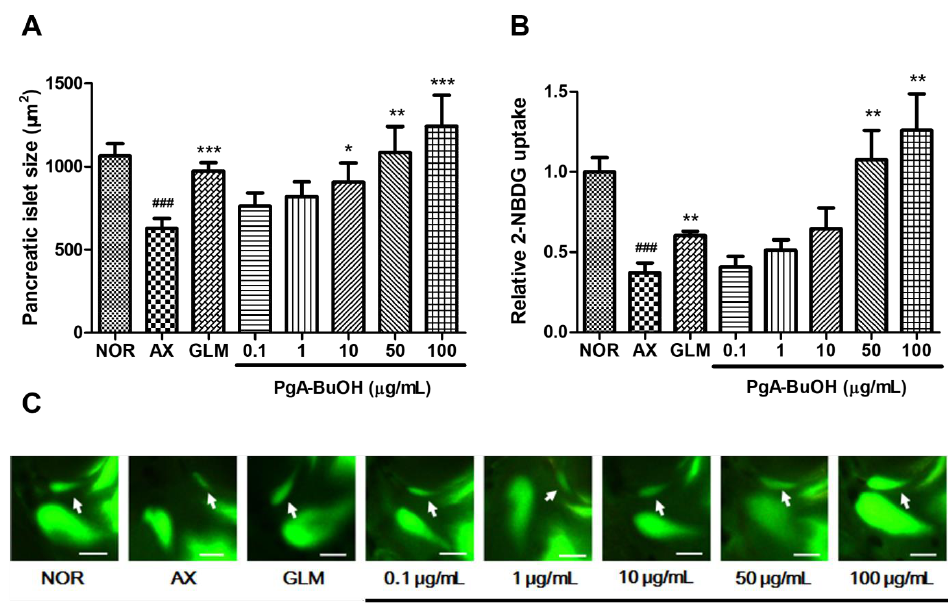
Figure 4. Dose-dependent effects of the PgA-BuOH fraction on alloxan-induced diabetic zebrafish. ( A ) Change in pancreatic islet size caused by the GLM and PgA-BuOH fraction; ( B ) relative 2-NBDG uptake in pancreatic islet caused by GLM and PgA-BuOH; ( C ) fluorescent microscopic images of the pancreatic islet. Scale bar = 100 μm (### p < 0.001; compared to NOR) (* p < 0.05, ** p < 0.01, *** p < 0.001; compared to AX). Scale bar = μm.